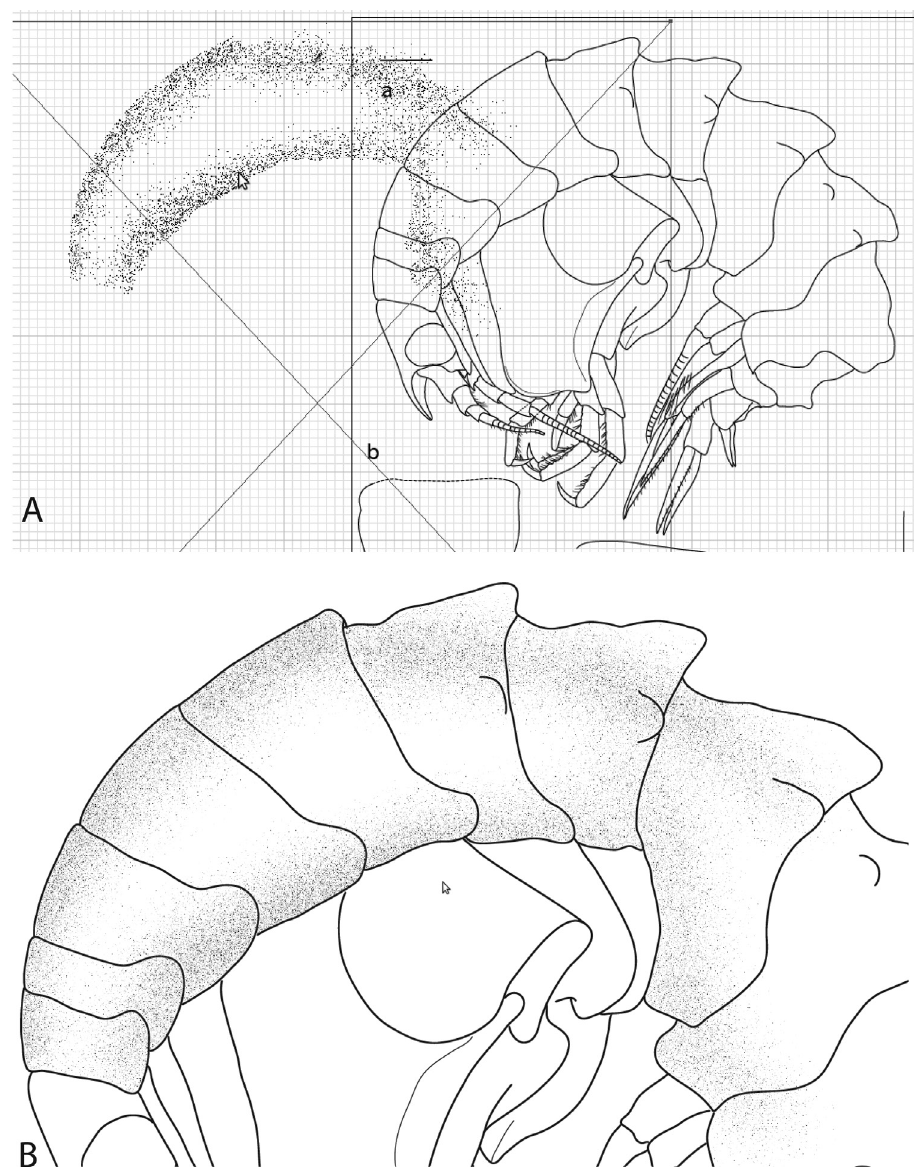
Figure 4. A) Place pixel cloud, saved without outlines from Photoshop into Illustrator using the File-Place command. B) Move the pixel cloud in the corresponding areas of the vector graphics in